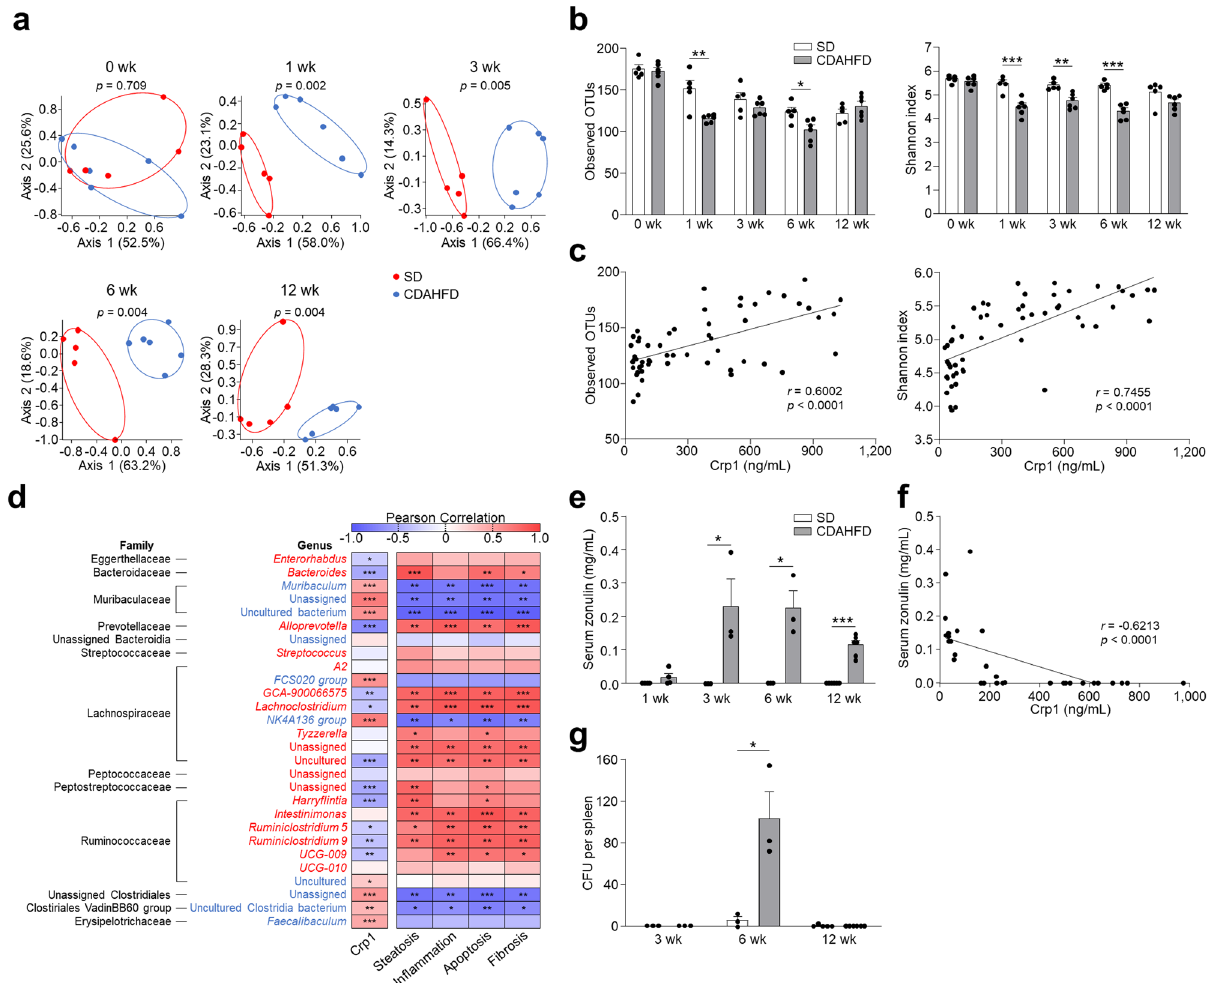
Figure 4. CDAHFD group shows dysbiosis correlated with both the quantity of α-defensin in feces and NASH pathology. ( a ) PCoA plot of intestinal microbiota based on weighted UniFrac distance of SD and CDAHFD groups. Significance was computed with PERMANOVA. ( b ) Observed OTUs and Shannon index in SD and CDAHFD groups. ( c ) Correlation analysis between fecal Crp1 levels and α-diversity indexes. ( d ) 28 genera that were significantly increased or decreased in the CDAHFD group compared with the SD group. Red indicates genera significantly increased in the CDAHFD group, and blue indicates genera significantly decreased in the CDAHFD group. Heatmap showing Pearson correlation coefficients between relative abundance of significantly changed genera in the CDAHFD group and fecal Crp1 levels from Fig. 2a or NASH pathology from Fig. 1b. Correlation analysis between Crp1 levels and relative abundance of individual genera was conducted using the data of 1, 3, 6, and 12 wk. Correlation analysis between NASH pathology and relative abundance of individual genera was conducted using the data of 12 wk. ( e ) Serum zonulin levels in SD and CDAHFD group. ( f ) Correlation analysis between fecal Crp1 and serum zonulin levels. ( g ) Quantification of bacteria in spleen by CFUs cultured from spleen of SD and CDAHFD group at 3, 6, and 12 w under anaerobic condition. Data are shown as mean ± SEM for n = 5–6 mice/group in ( a , b , c , d ). Data are shown as mean ± SEM for n = 3–6 mice/ group in ( e , f , g ). * P < 0.05, ** P < 0.01 and *** P < 0.001, by unpaired two-tailed Student’s t test ( b , e , g ) and Pearson correlation test ( c , d , f